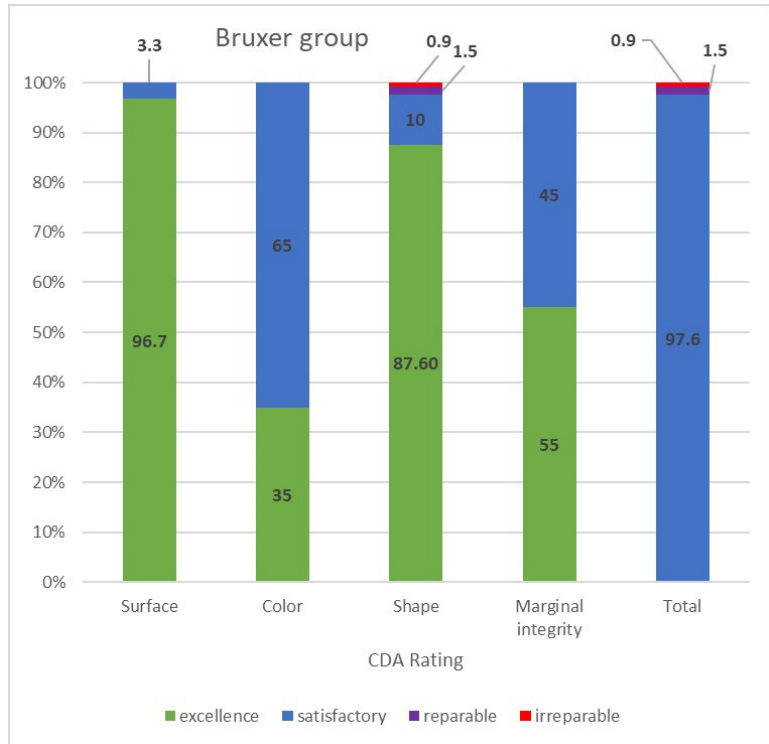
Figure 3. CDA ratings for the bruxer group .